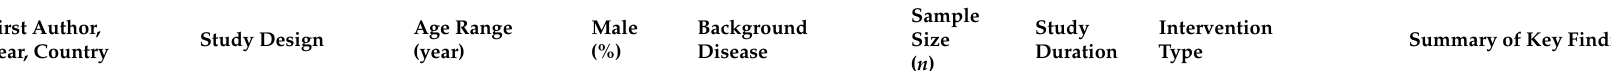
Table 1. Characteristics of included